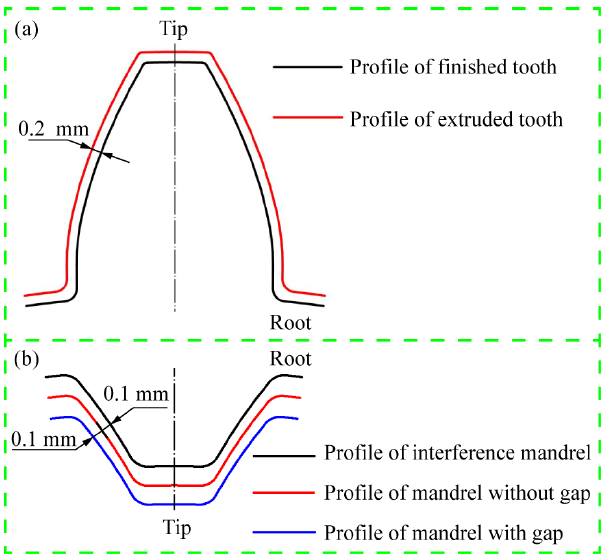
Figure 2. Schematic view of different finishing tools for sun gear: ( a ) Outer teeth and ( b ) inner teeth.